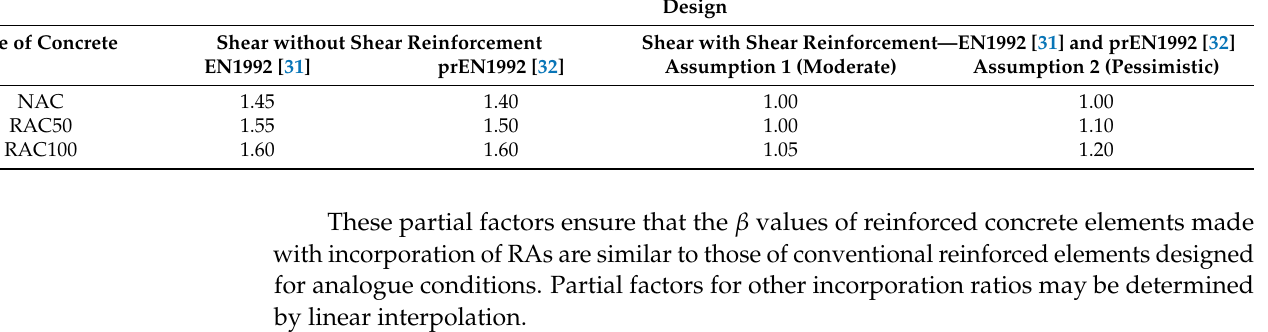
Table 11. Recommended partial factors for shear design of NAC and RAC elements.